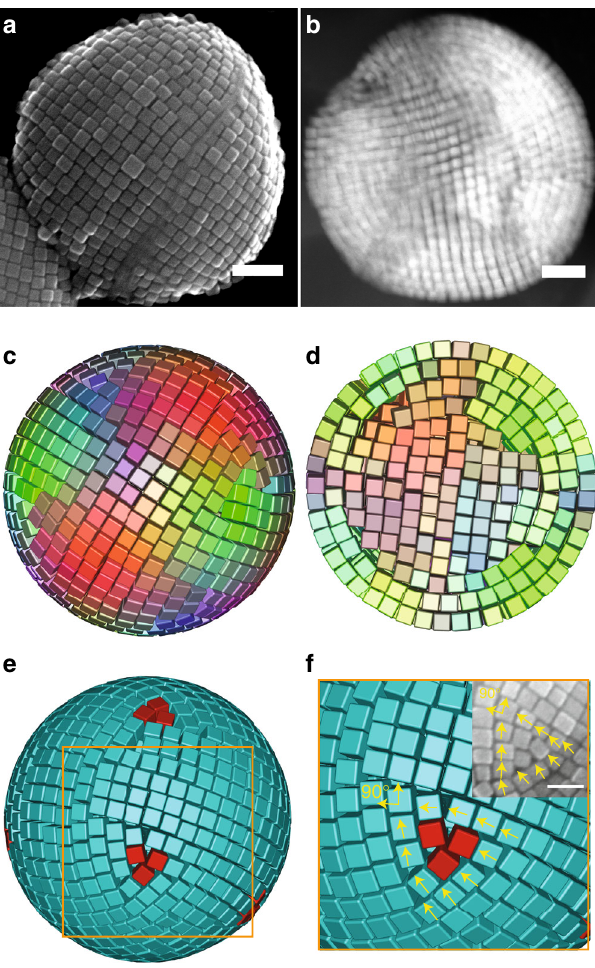
Fig. 2 SPs consisting of sharp nanocubes. a SEM and b cryo-HAADF-STEM images of a SP containing sharp Fe 3 O 4 nanocubes, simulation results of c surface, and d core termination of a SP resulting from the SA of sharp cubes ( α = 0.8) in spherical con fi nement, note that different colors represent different orientations (Supplementary Methods Sections 3 and 4). e , f topological defects as denoted by red. Inset, disclination found in experiment. For an interactive 3D view of c and e , see Supplementary Data 1 and 2, respectively. Scale bars, a , b 100 nm, inset in f , 50 nm theoretical model: α core ≈ 0.73 (Fig. 1d) for the Fe 3 O 4 nanocubes and α core ≈ 0.35 (Fig. 1e) for the Fe x O/CoFe 2 O 4 nanocubes. The nanocubes are stabilized by ligands, oleic acid molecules in our case. To take into account the effect of the ligands we assume that they form a shell of constant thickness L around the hard core of the particle. We have obtained the thickness of the ligand layer L = 1.4 nm from the particle separation by comparing the simulated radial distribution function g ( r ) as a function of the particle separation r with the experimentally obtained g ( r ) (see Supplementary Methods Section 2.3). Taking into account the ligands, the total shape parameter α of the Fe 3 O 4 nanocubes and Fe x O/CoFe 2 O 4 nanocubes is 0.68 and 0.30, respectively (see Supplementary Methods Section 2.3 for more details). It is likely that the NP interactions are not exclusively hard and that non- spherical NPs at the droplet interface induce more complex interactions 12,42 . However, the good correspondence between our experiments and the simulations, in which these interactions are not taken into account, indicates that the experimental SA is largely determined by entropy.